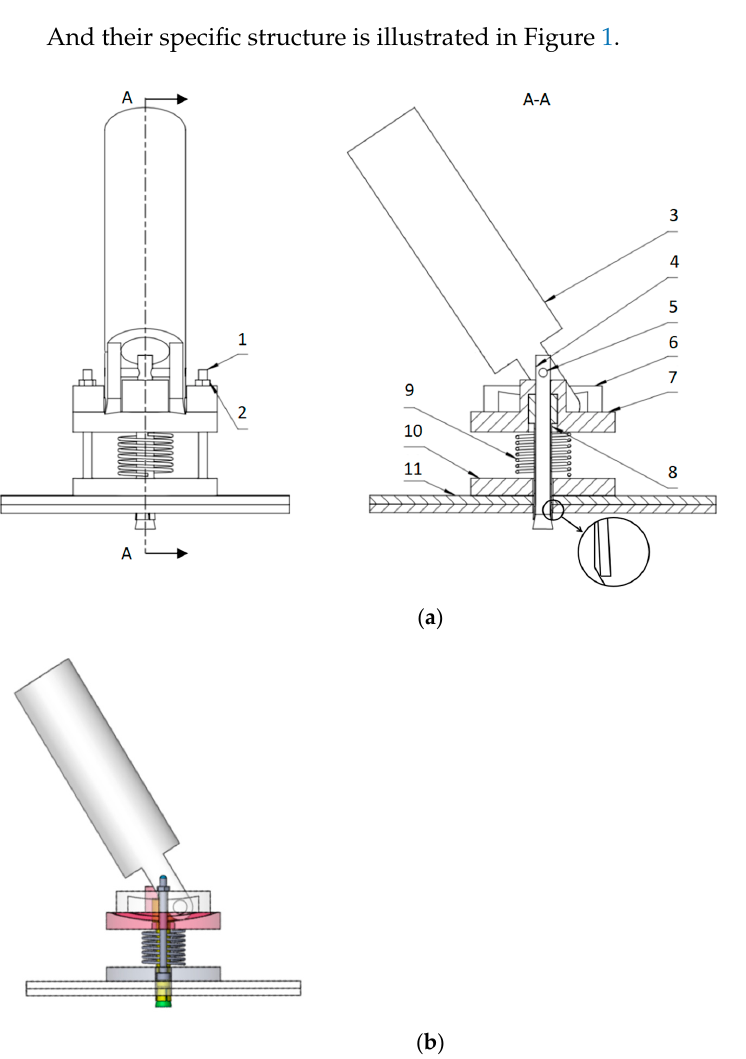
Figure 1. ( a ) Two-dimensional diagram of new temporary fasteners. 1—Adjusting bolt; 2—Adjusting nut; 3—Leverage; 4—Expansion shaft; 5—Pin shaft; 6—Chute cover; 7—Chute table; 8—Expansion anchor; 9—Spring; 10—Adjustment board; 11—Workpiece; ( b ) Three-dimensional diagram of tempo- rary